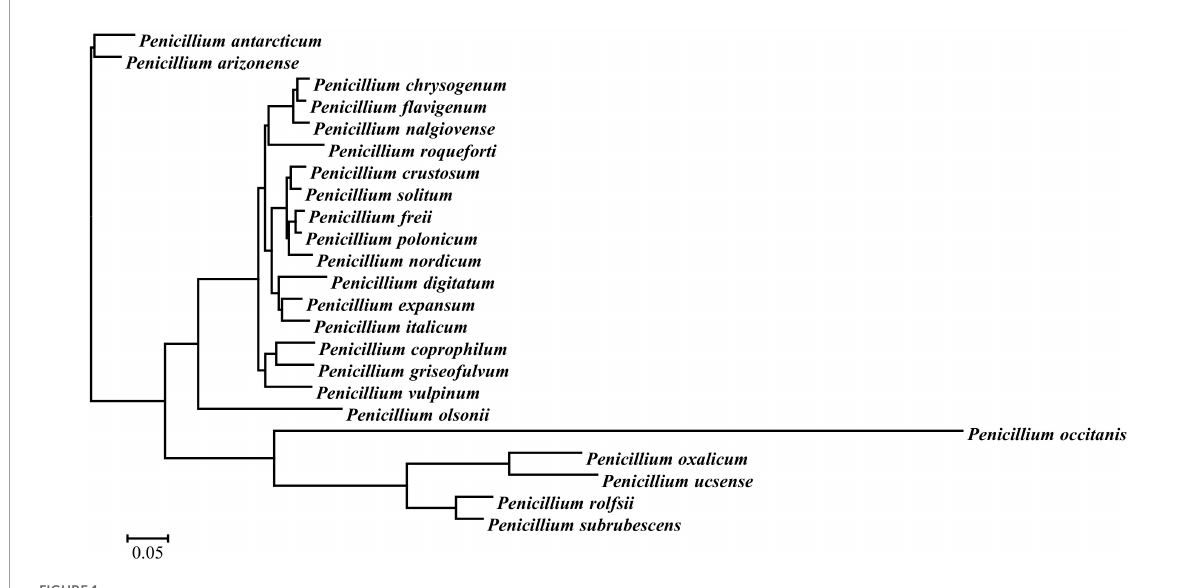
FIGURE1 Phylogenetic tree for selected single-copy orthologous sequences in the genomes of Penicillium olsonii WGH5 and 23 other Penicillium species.